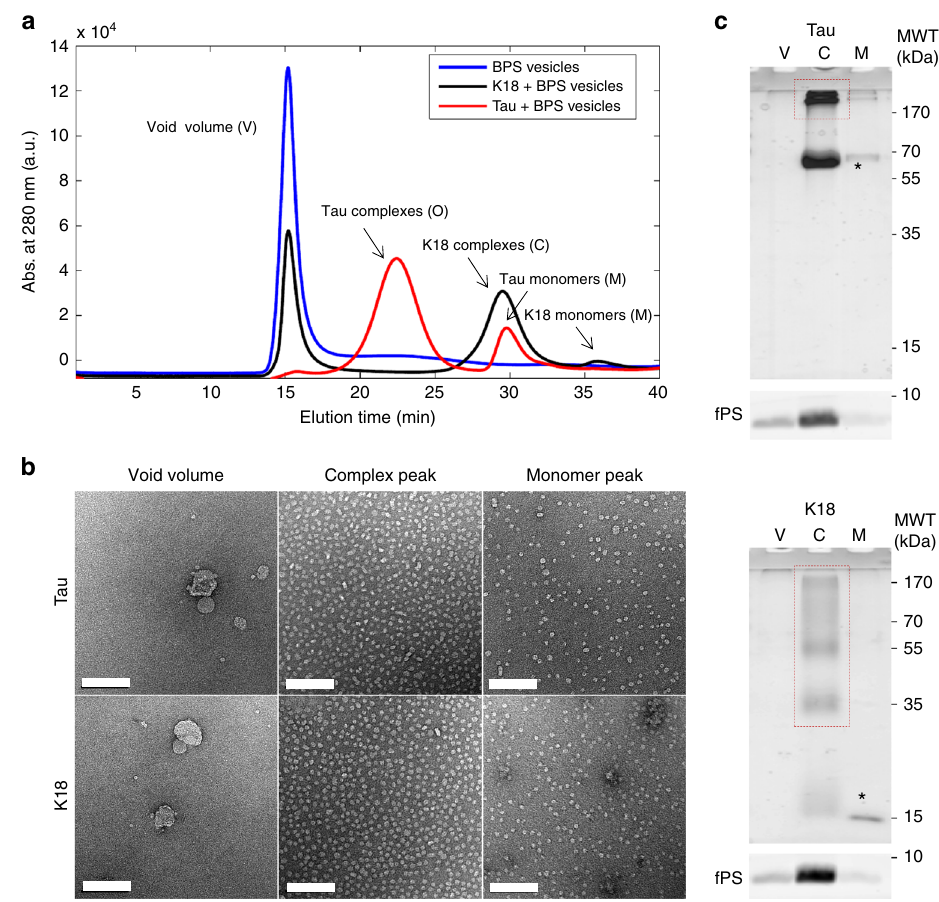
Fig. 2 Characterization of the Tau and K18 protein/phospholipid complexes. a Chromatograms of BPS vesicles alone (blue) and after incubation for 24 h with K18 (black) and Tau (red) at a molar protein:phospholipid ratio of 1:20. The samples were run on a Superose 6 column at a fl ow rate of 0.5 ml min − 1 . Vesicles eluted in the void volume (15 min), globular particles formed by Tau and K18 eluted between 20 and 25 min and between 27 and 32 min, respectively, and monomeric Tau and K18 eluted at 30 min and 36 min, respectively. b Negative-stain EM images of the void volume, the globular particles, and monomer fractions of Tau (top) and K18 (bottom). The scale bars are 100 nm. c SDS-PAGE gel of the void volume (V) and the peaks representing the protein/phospholipid complexes (C) and the monomers (M) obtained with Tau (top) and K18 (bottom). The asterisks mark bands of monomeric proteins and the dashed red rectangles indicate oligomeric species. The phospholipids, containing 1% NBD-labeled phospholipids, which were imaged separately with a Typhoon trio fl uorescent scanner, are shown on the bottom (labeled